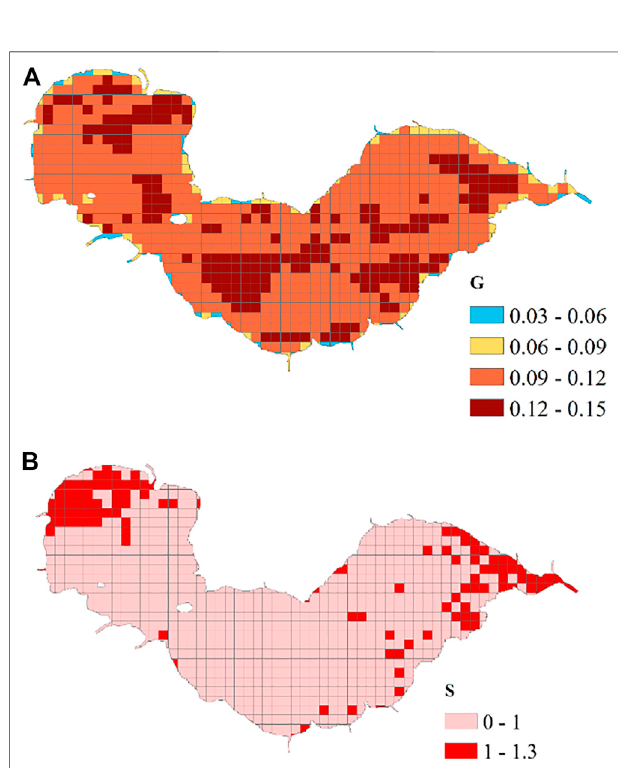
FIGURE 12 | Map of (A) Gini coef fi cient and (B) Lorenz asymmetry coef fi cient for each grid cell.